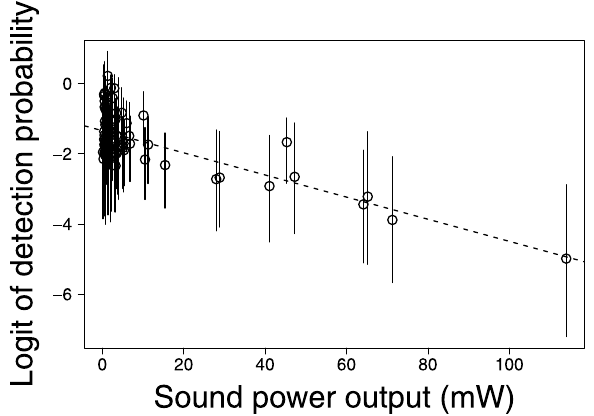
Figure 6. Estimated probability of detection (on logit scale with 95% credible interval) vs. sound power output (mW) of each species.